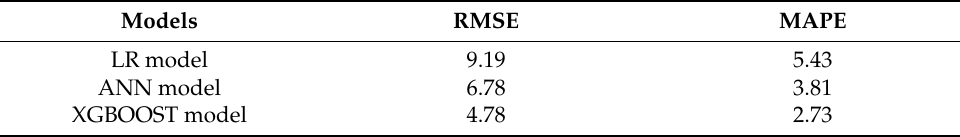
Table 6. The RMSE and MAPE of the three electricity consumption models.